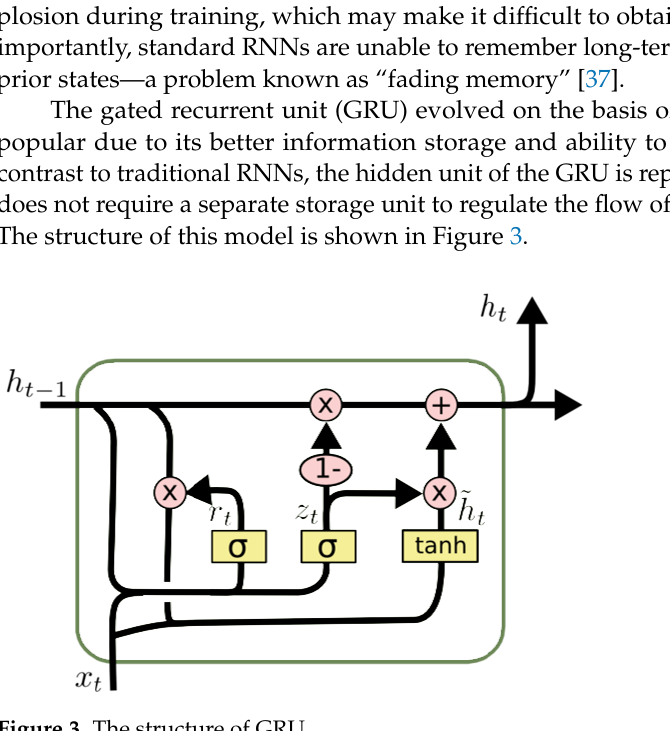
Figure 3. The structure of